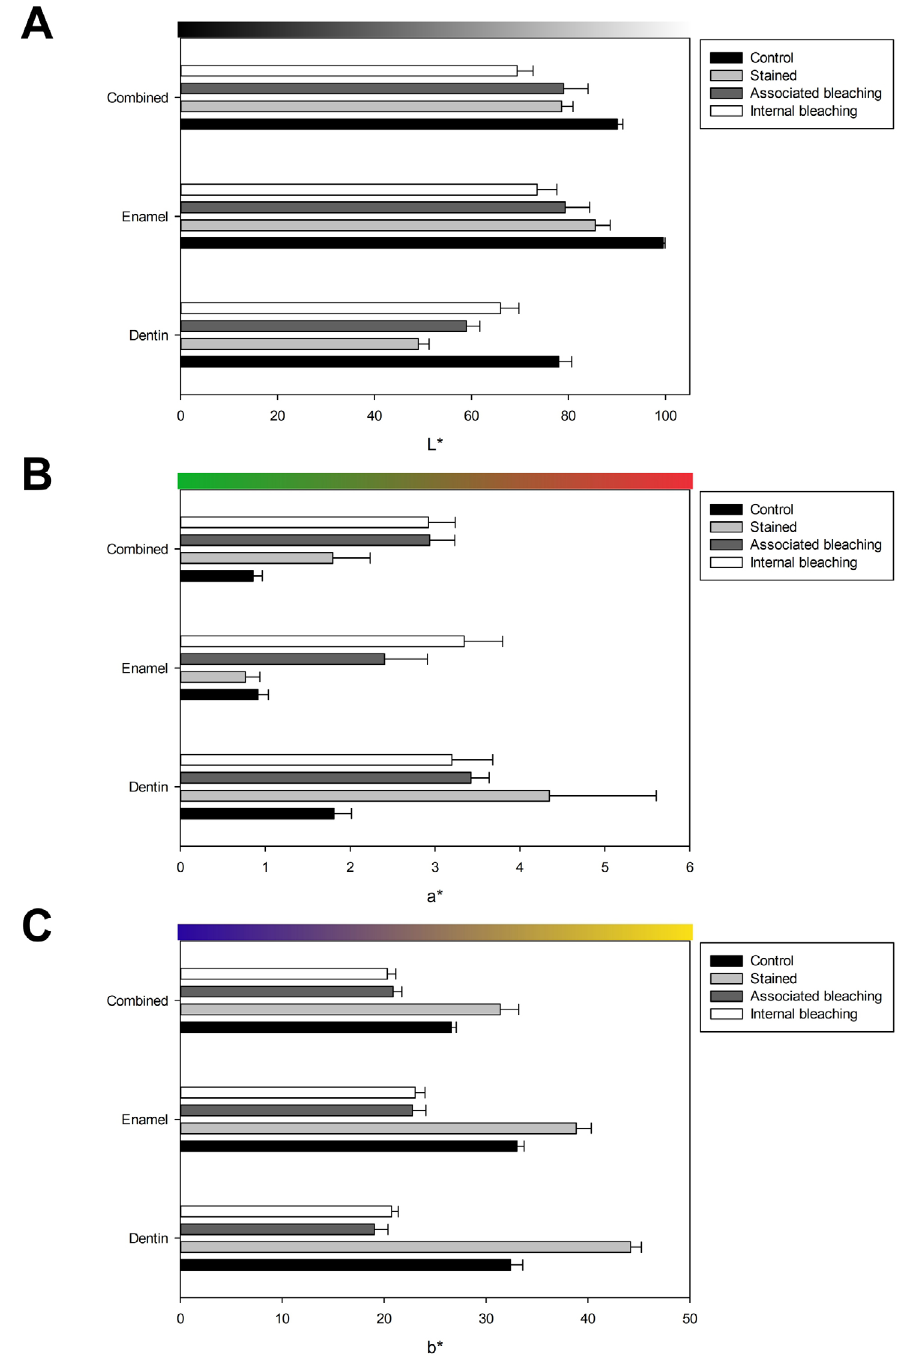
Figure 2- Color parameters behavior due to staining and bleaching procedures measured on dentin, enamel, or combined tissues. (A) – L* parameter measuring lightness, (B) – a* parameter for red-to-green axis, and (C) – b* parameter for yellow-to-blue